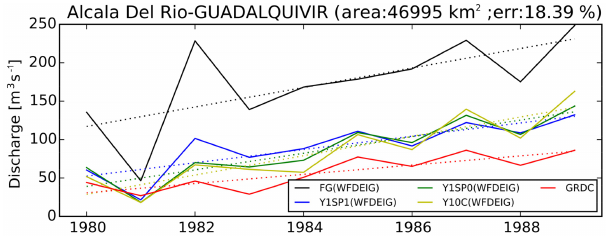
Figure 7. The annual cycles of river discharge for “First Guess” (FG) forced by WFDEI-GPCC (black), Y1SP1 (blue), Y1SP0 (green), Y10C (yellow) and GRDC observations (red) over the Al- cala Del Rio station (37.52 ◦ N, − 5.98 ◦ W) on the Guadalquivir river. The dotted lines show the